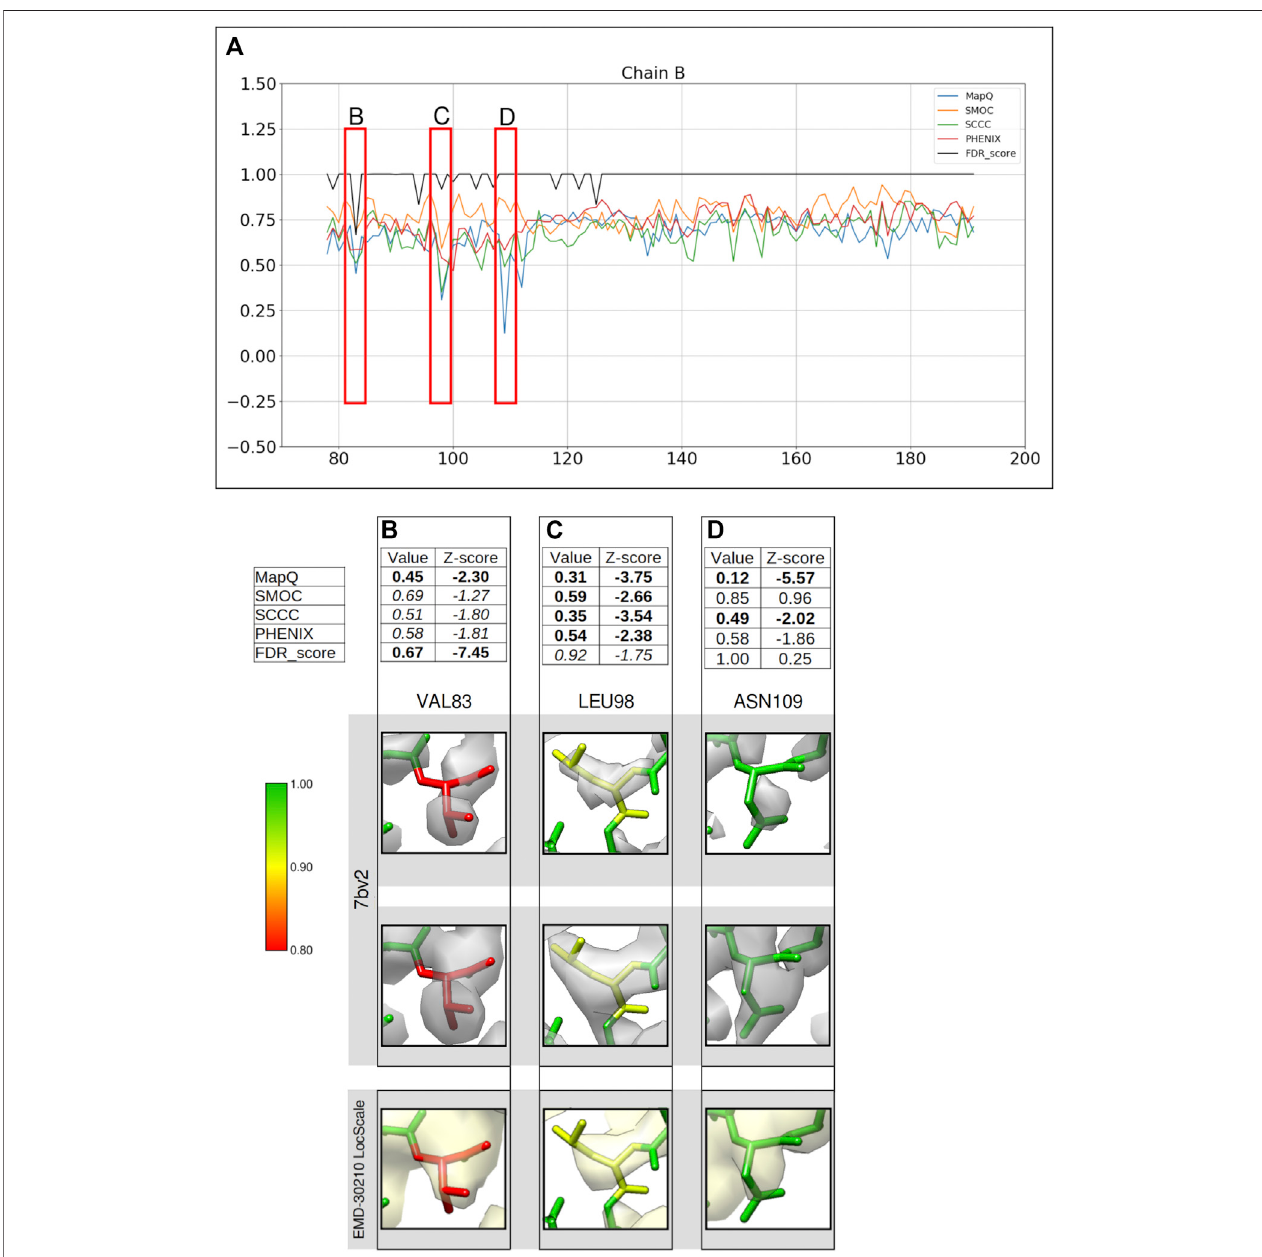
FIGURE 5 | Comparison of backbone validation metrics for the atomic model of the RNA polymerase complex (PDB ID: 7bv2). (A) Comparison of the per-residue scores from MapQ, SMOC, SCCC, PHENIX, and FDR backbone score for the chain B of the atomic model, the red boxes highlights the residues selected for detailed analysis in the panels below. For Val 83 (B) , Leu 98 (C) , and Asn 109 (D) , the panel shows a table with values of scores obtained with each metric and corresponding Z-scores; the residue fi t in the target map (EMD-30210, grey) displayed at the recommended contour level and rendered in UCSF Chimera; the residues fi t in the map rendered at a lower contour